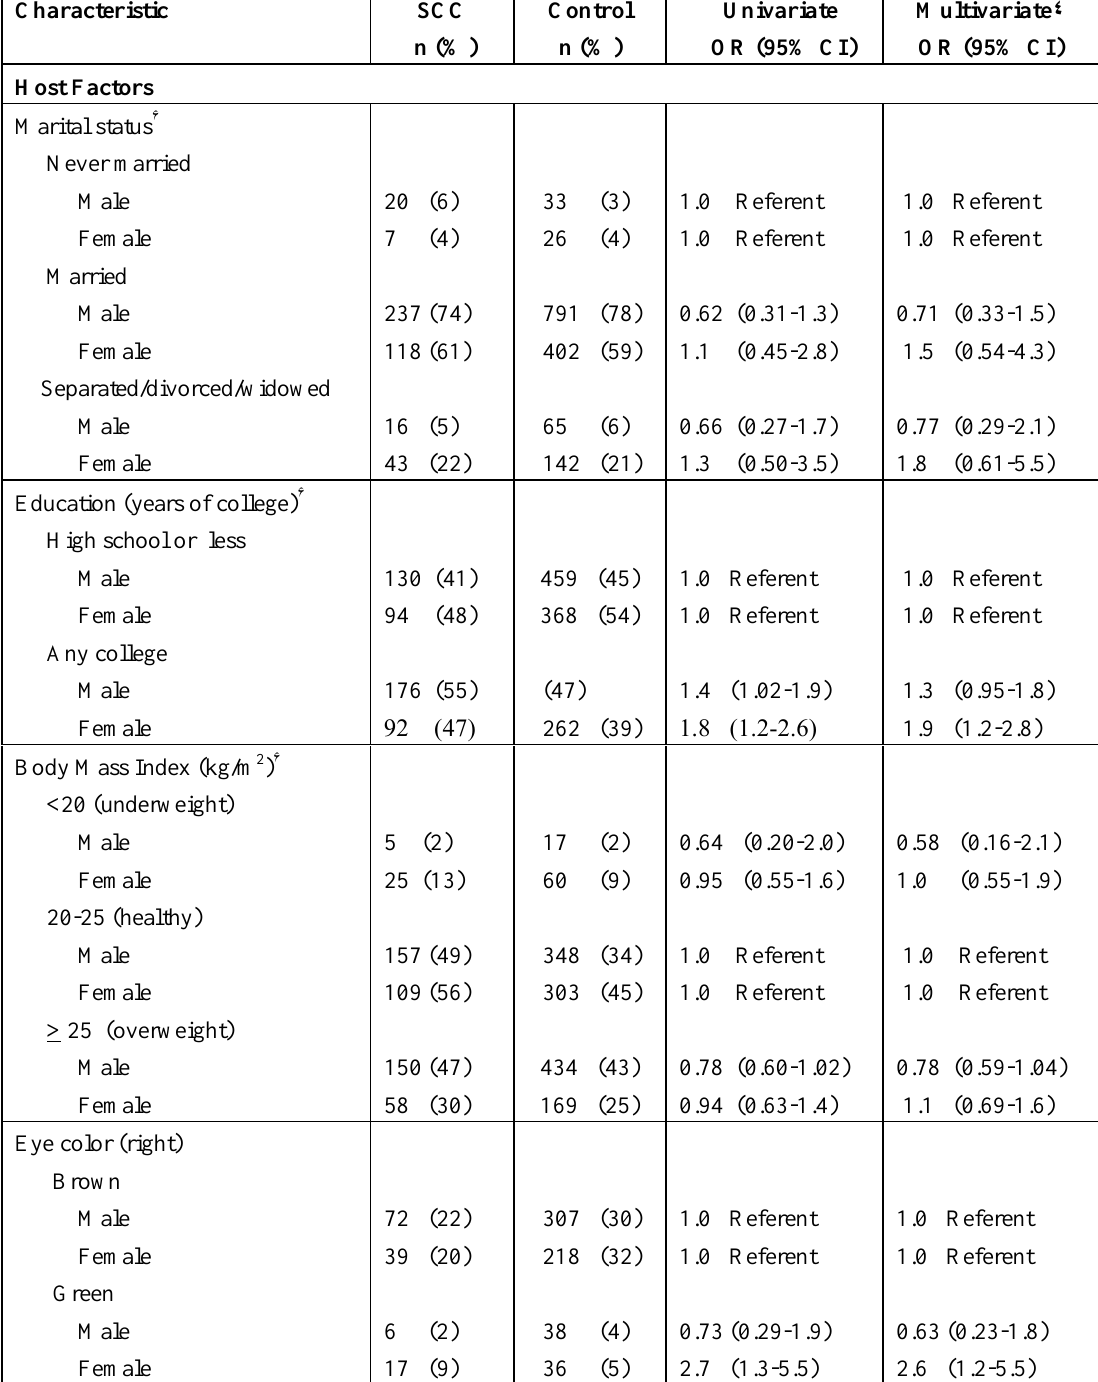
Table 1. Conditional logistic regression models comparing cases and